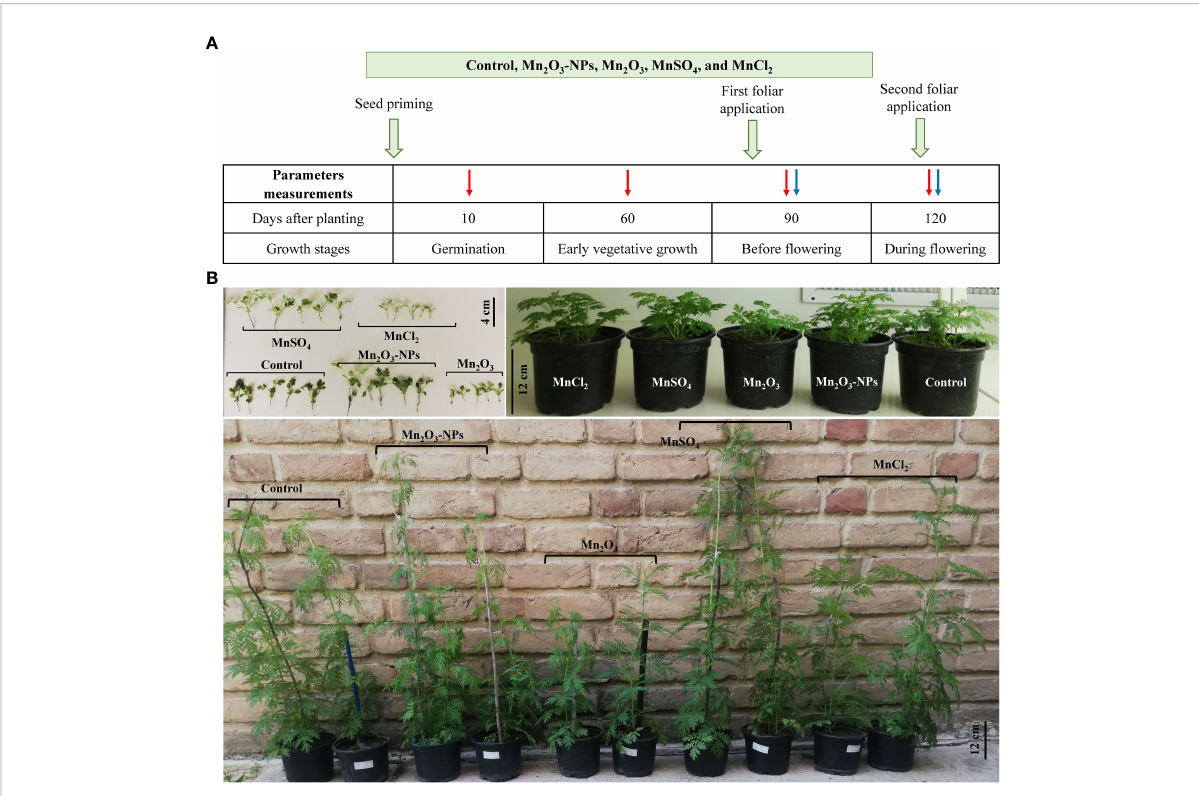
FIGURE 1 Schematic design of the treatments in the experiment (A) ; the orange arrows indicate the time of treatments; the red and blue arrows show the parameters measured time-intervals in SP and SP+F conditions, respectively, to investigate the effects of Mn treatments in A. annua . Figure (B) is related to the plant growth at seedlings (top-left), 60 days (top-right) and 120 days (bottom) after planting. In the bottom fi gure, the post labeled in white are related to the SP